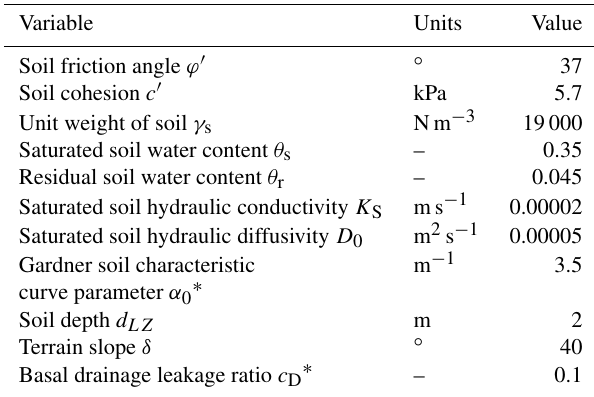
Table 1. Soil and morphological properties of a representative hill- slope in the Peloritani Mountains area, Sicily, Italy (after Peres and Cancelliere, 2014).